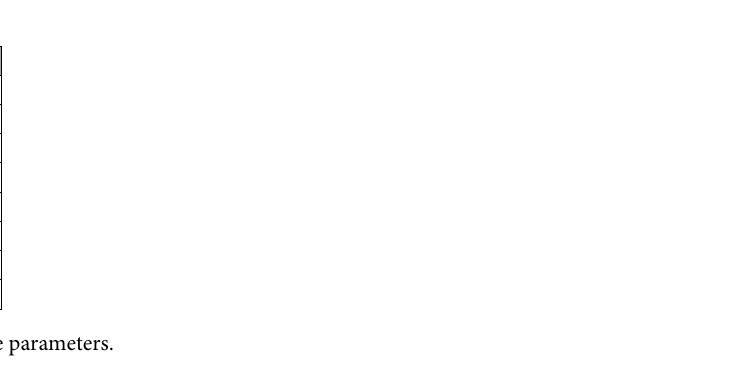
Table 3. Balance control parameters.